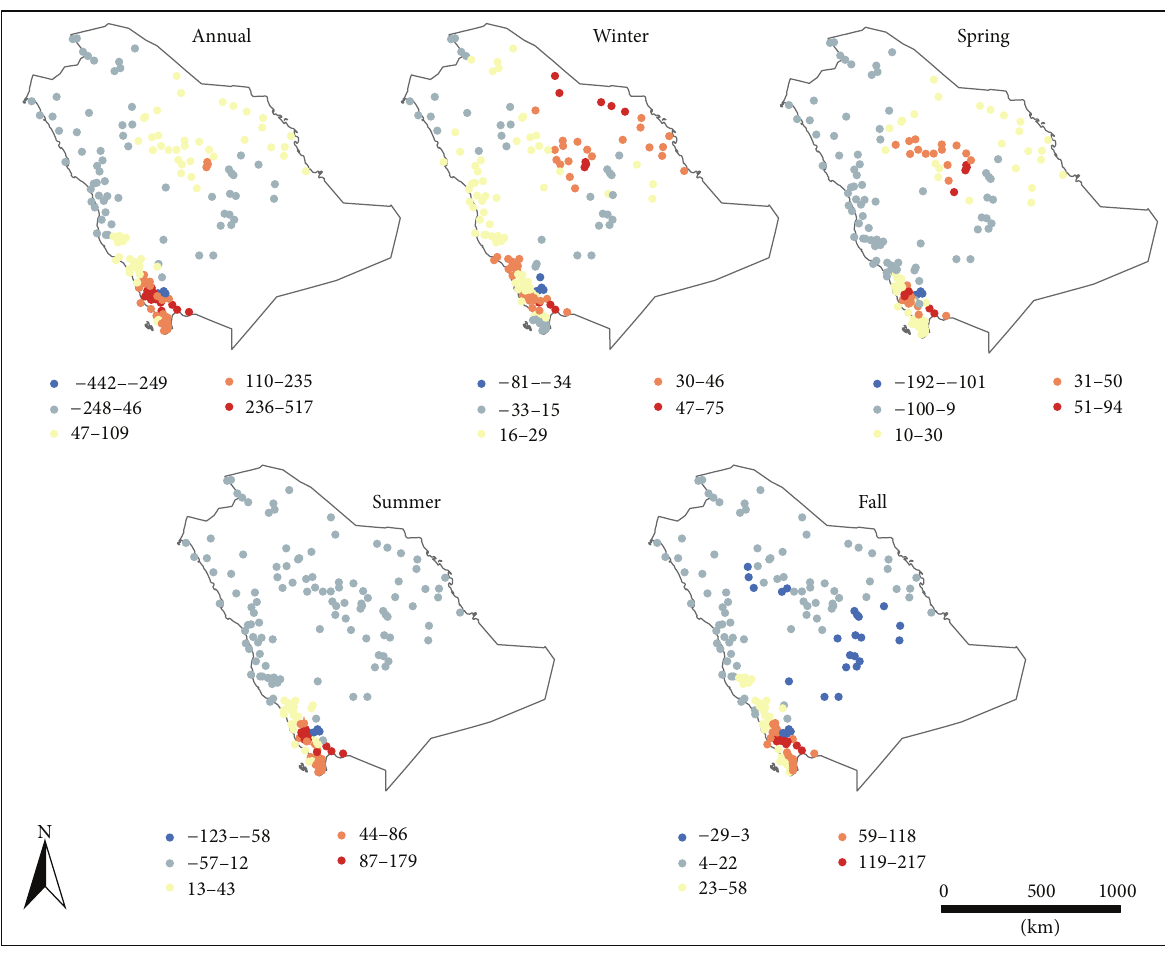
Figure 10: GWR parameter estimation of the intercept for annual and seasonal rainfalls. Table 3: Observed versus estimated mean amount of annual and seasonal rainfalls (1971–2005) using GWR. Observed Season